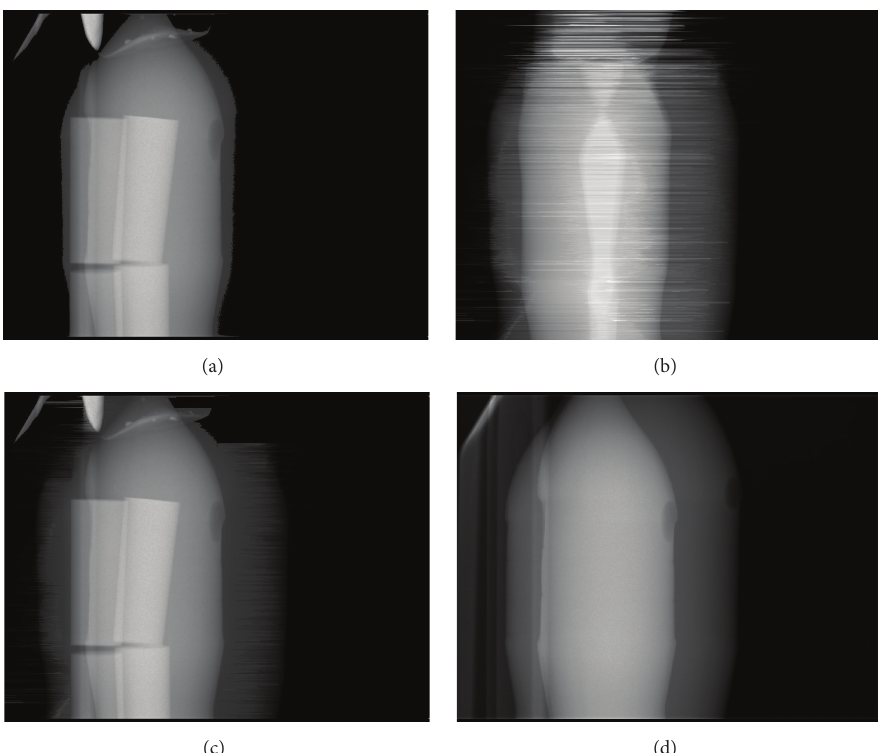
Figure 10: An uncorrected projection is shown in (a). (b) shows the intersection lengths that have been calculated for the projection geometry as in (a). Based on these intersection lengths, the saturated projection is extrapolated. The resulting corrected projection is illustrated in (c) and can be compared to the ground truth in (d). Window levels (a), (c), and (d): [0, 8]. Window level (b): [0,